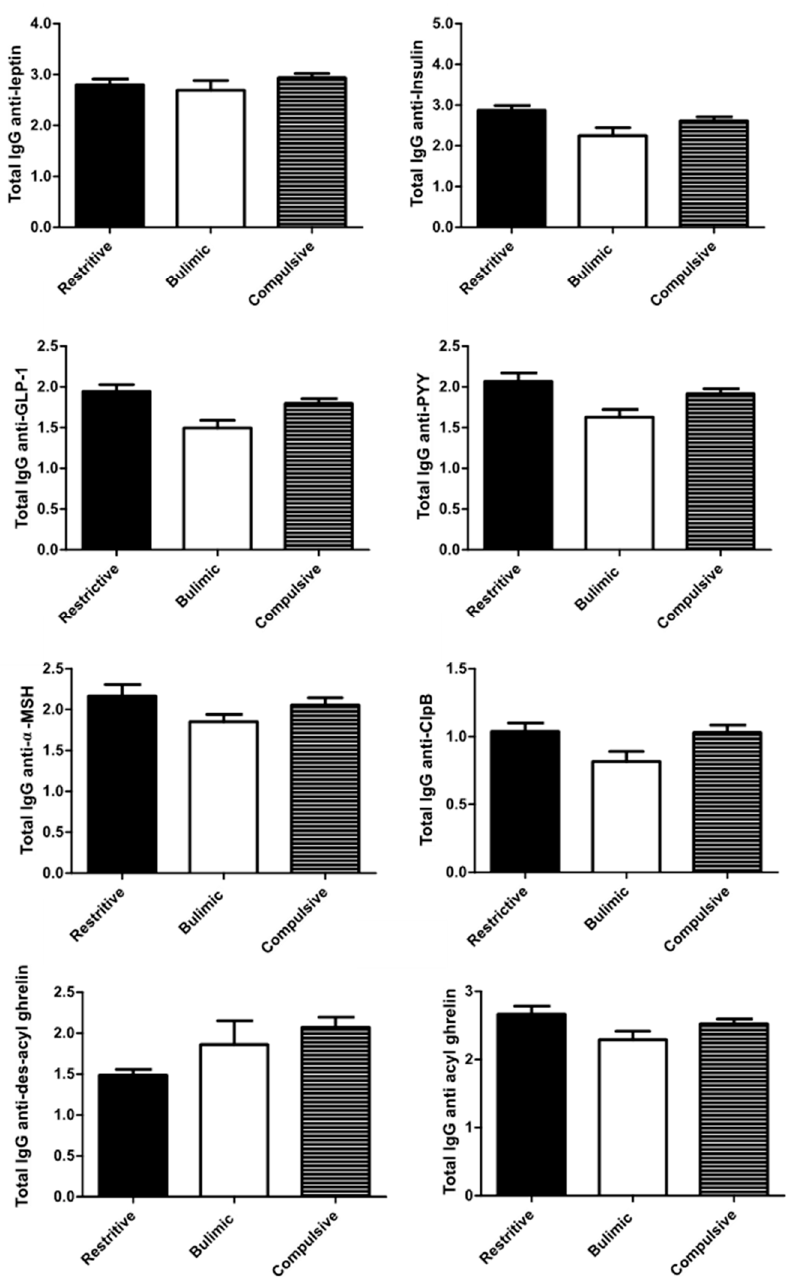
Figure 2. Total plasma IgG against peptides associated with food intake according to broad categories of ED. The standard deviation is represented by the error bar.